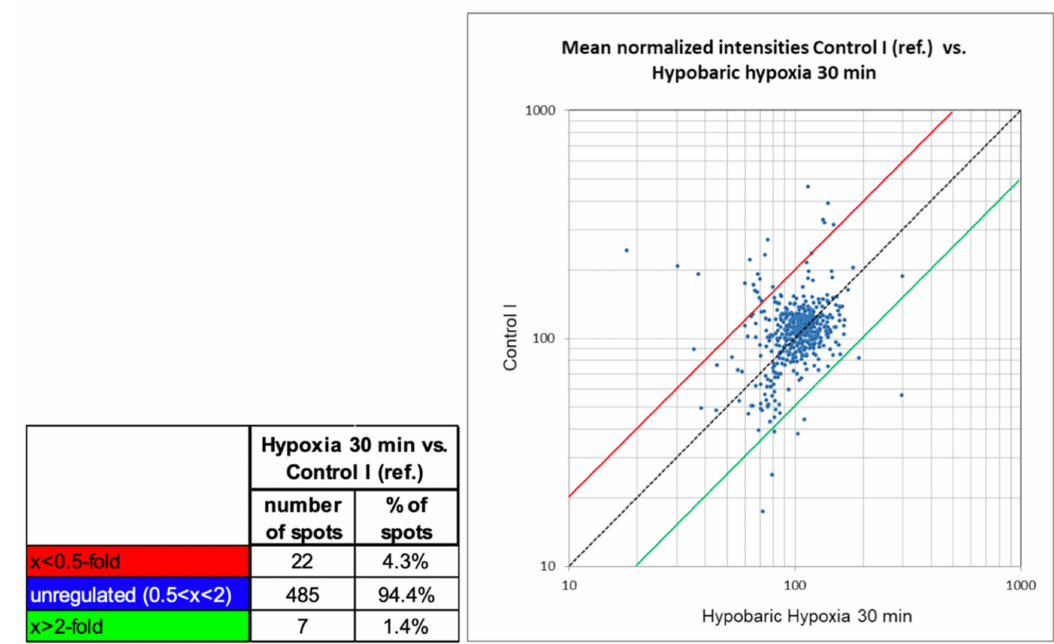
Figure 1. Summary of quantitative changes of comparison 1: HH30 versus GC30. The differentially expressed protein spots between the two samples of comparison 1 are shown in the 2D gel image in Figures 2 and 3. Spot ratios >1 indicate a higher spot intensity in sample HH30; spot ratios <1 indicate a higher spot intensity in sample GC30.